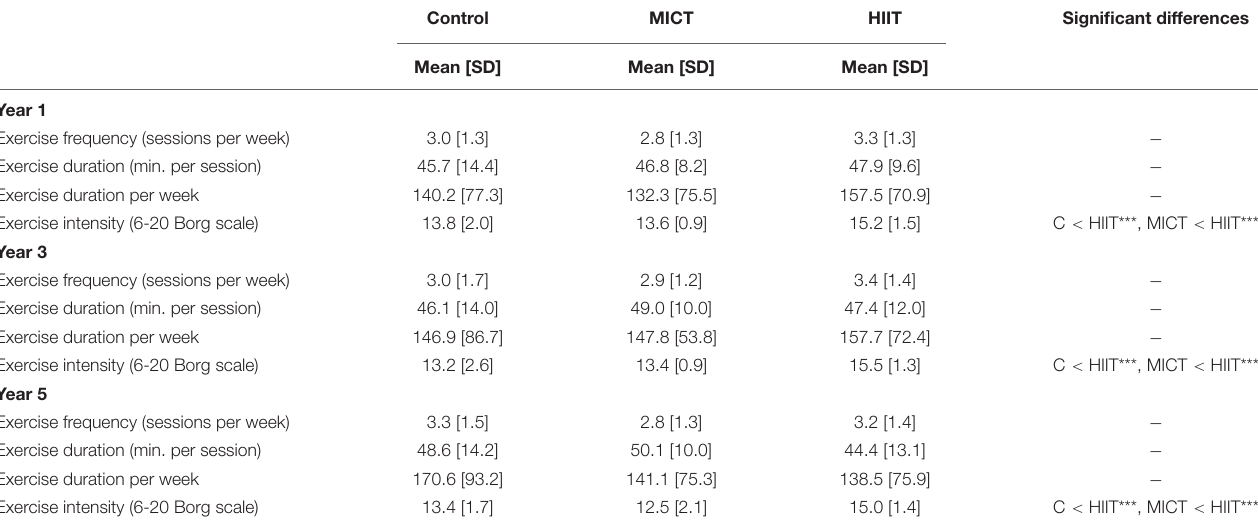
TABLE 4 | Exercise frequency, duration, and intensity in the control, moderate-intensity continuous training, and high-intensity interval training groups. Control MICT